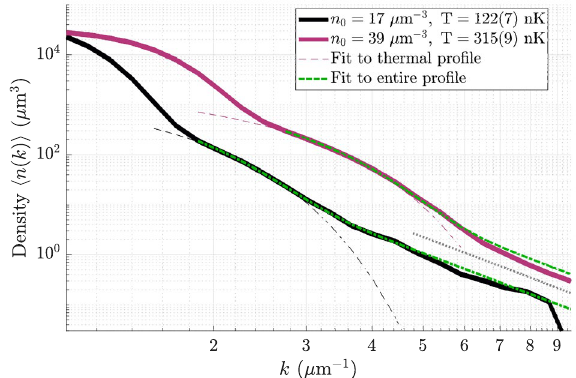
Figure 1. The measured far-field density of particle momenta from two trap configurations (black and magenta). Three regions are shown: At low k the parabolic distribution of the BEC dominates. For larger k , the 2 thermal parts (fits shown by dashed lines) decay super-exponentially as e − k . For even larger k , these give way C 4 / k 4 (green dot-dash lines) to the surmised quantum depletion region. A combined fit of the form n T ( k ) + yields temperatures consistent with the thermal fit and also an amplitude C 4 of the depleted tail. The grey dotted line is a guide to the eye showing a k − 4 decay. Due to constraints of the detector geometry (see Supplementary Materials for details), these profiles were integrated over two spherical segments, each subtending an angle of π/ 6 radians with the z axes (see also Fig. 5). The detector shows signs of saturation for low k ( (cid:31) 1.5 µ m − 1 ). ± These factors imply the total area under the curves is less than the average number of trapped